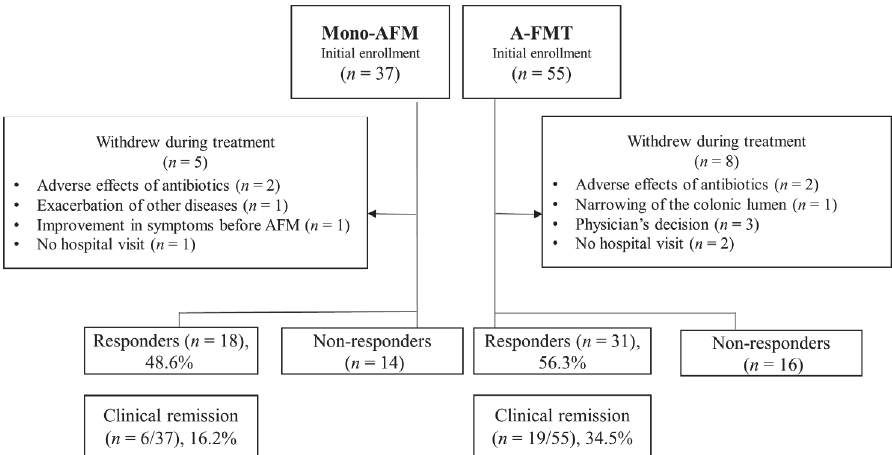
Figure 1. Flow diagram of this study for short-term evaluation. Ninety-two patients were enrolled in our study: 37 patients in the mono-AFM (triple antibiotic therapy (amoxicillin, fosfomycin, and